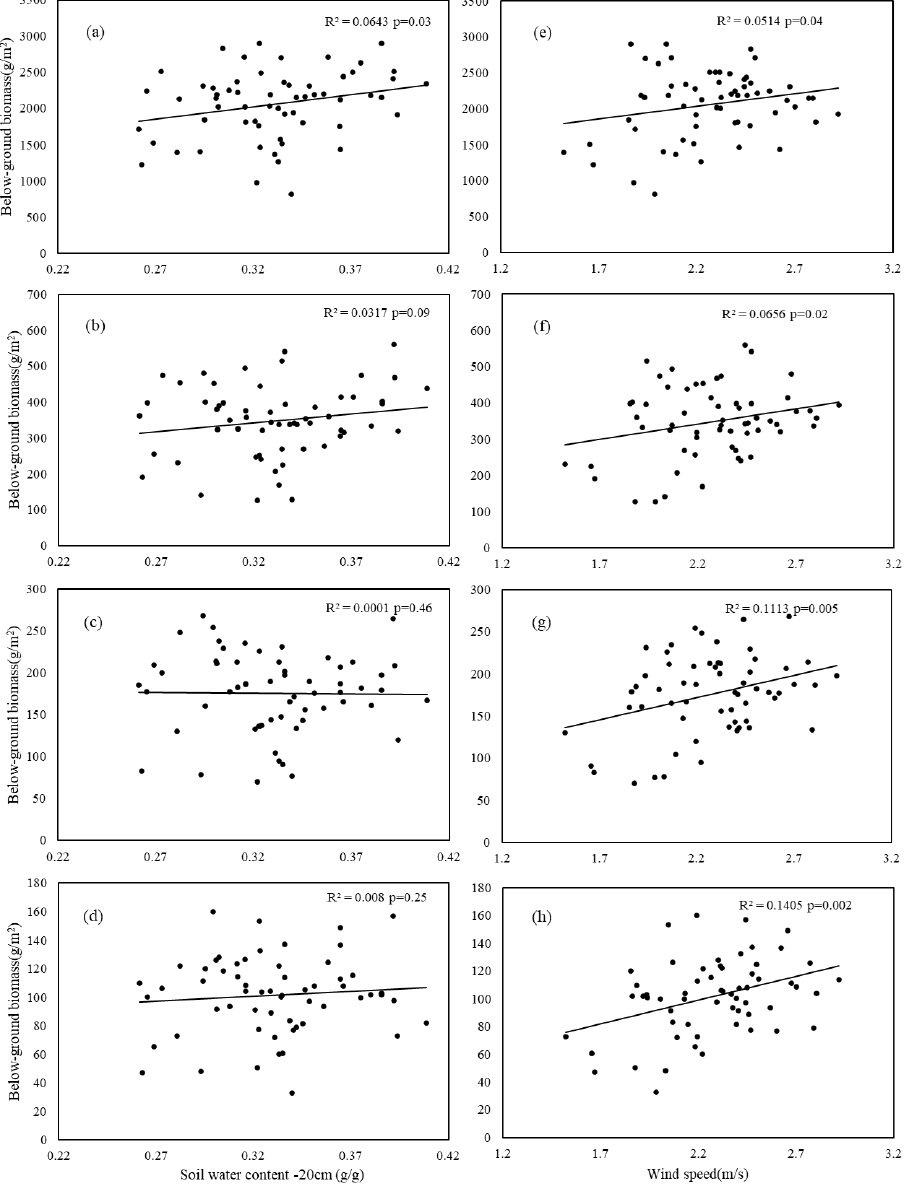
Figure 12. Relationship between soil water content of 20 cm soil depth and 0–10 cm below-ground biomass ( a ), 10–20 cm below-ground biomass ( b ), 20–30 cm below-ground biomass ( c ) and 30–40 cm below-ground biomass ( d ), between wind speed and 0–10 cm below-ground biomass ( e ), 10–20 cm below-ground biomass ( f ), 20–30 below-ground biomass ( g ), 30–40 cm below-ground biomass ( h ).